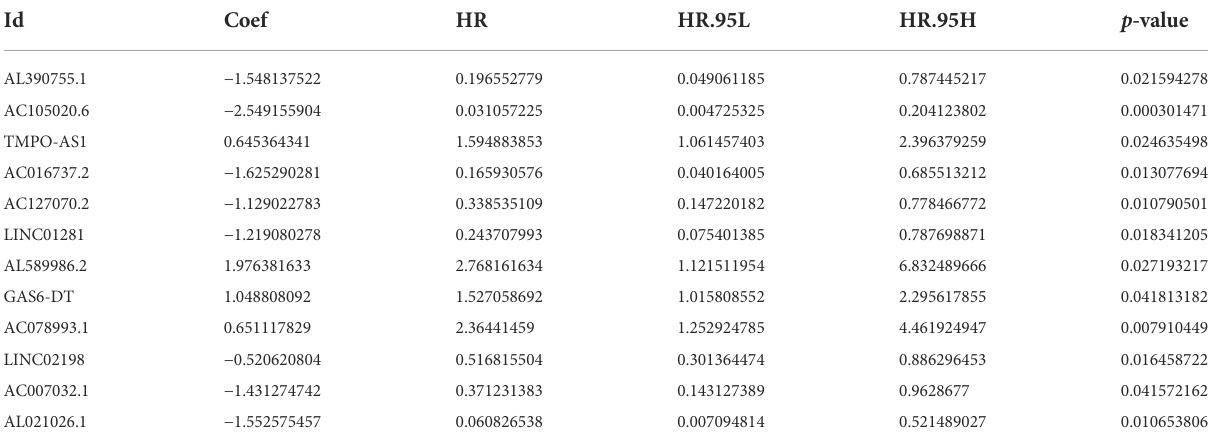
TABLE 2 The 12 FAM-related prognostic